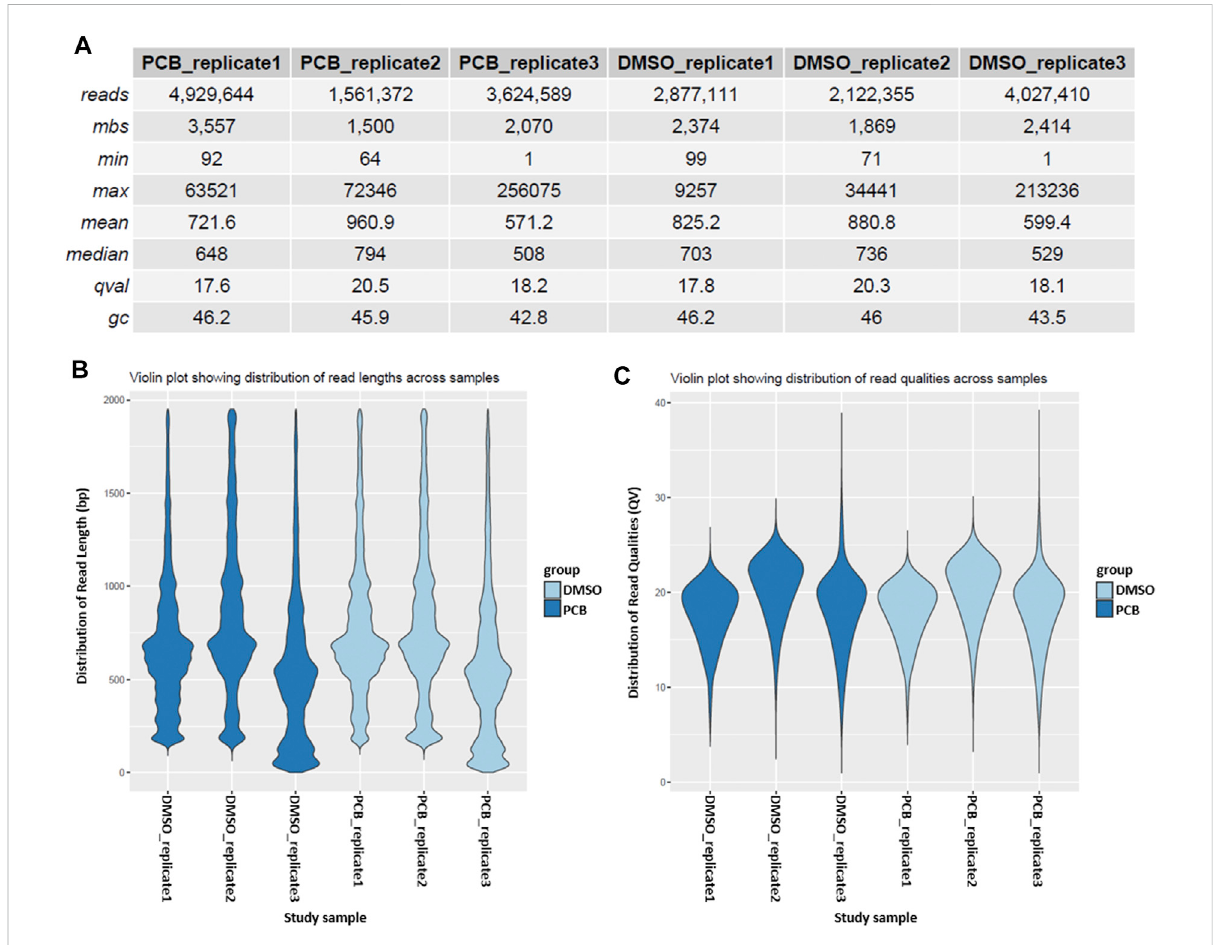
FIGURE 3 Sample summary and quality control. (A) Summary of the reads of every sample. The table provides information about the number of reads, million base sequences ( mbs ), minimal and maximum read length, mean and median read length, quality score ( qval ), and GC content ( gc ). Violin plots depict the distribution of read length (B) and the distribution of read quality (C) across different